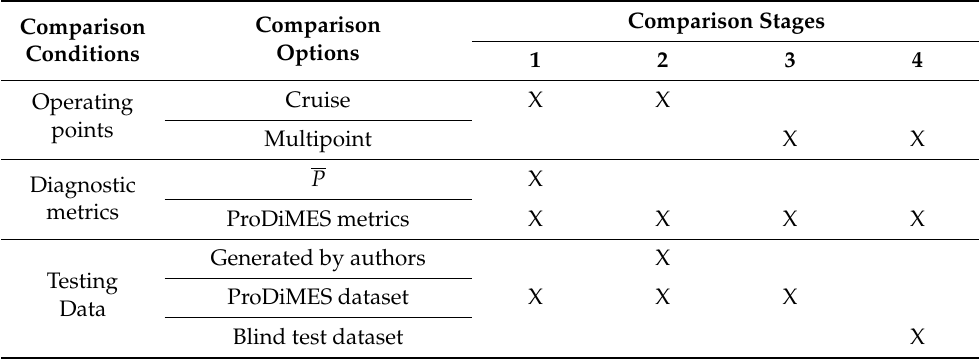
Table 4. Conditions and stages of